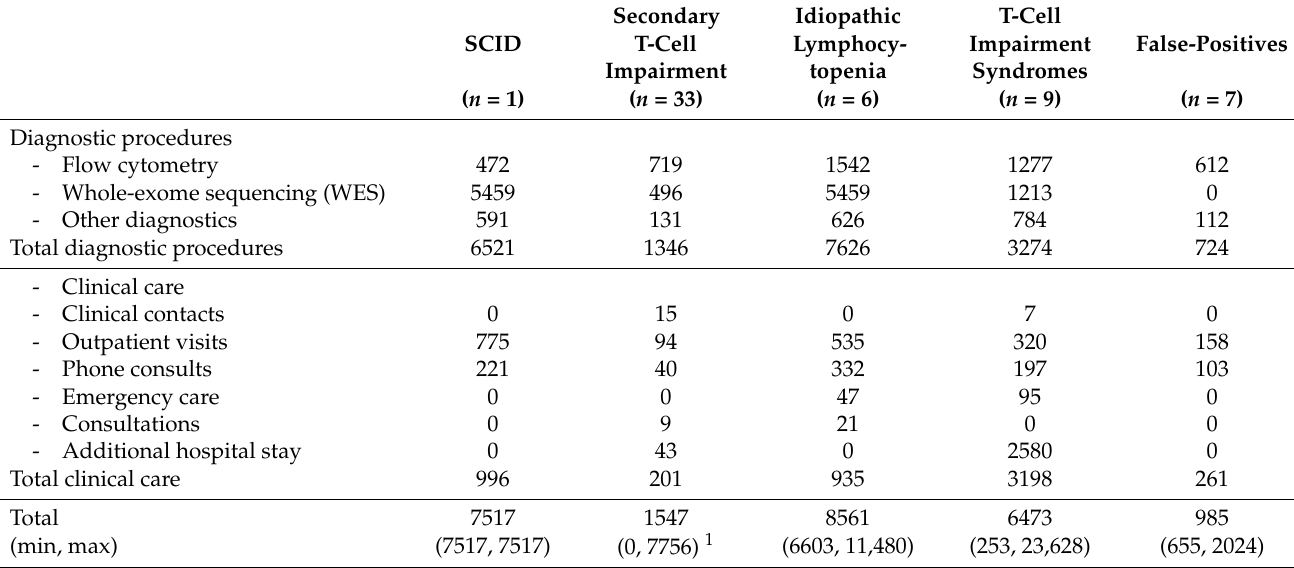
Table 3. Average costs per child of diagnostic procedures and clinical care in screen-positive newborns in SONNET-study in